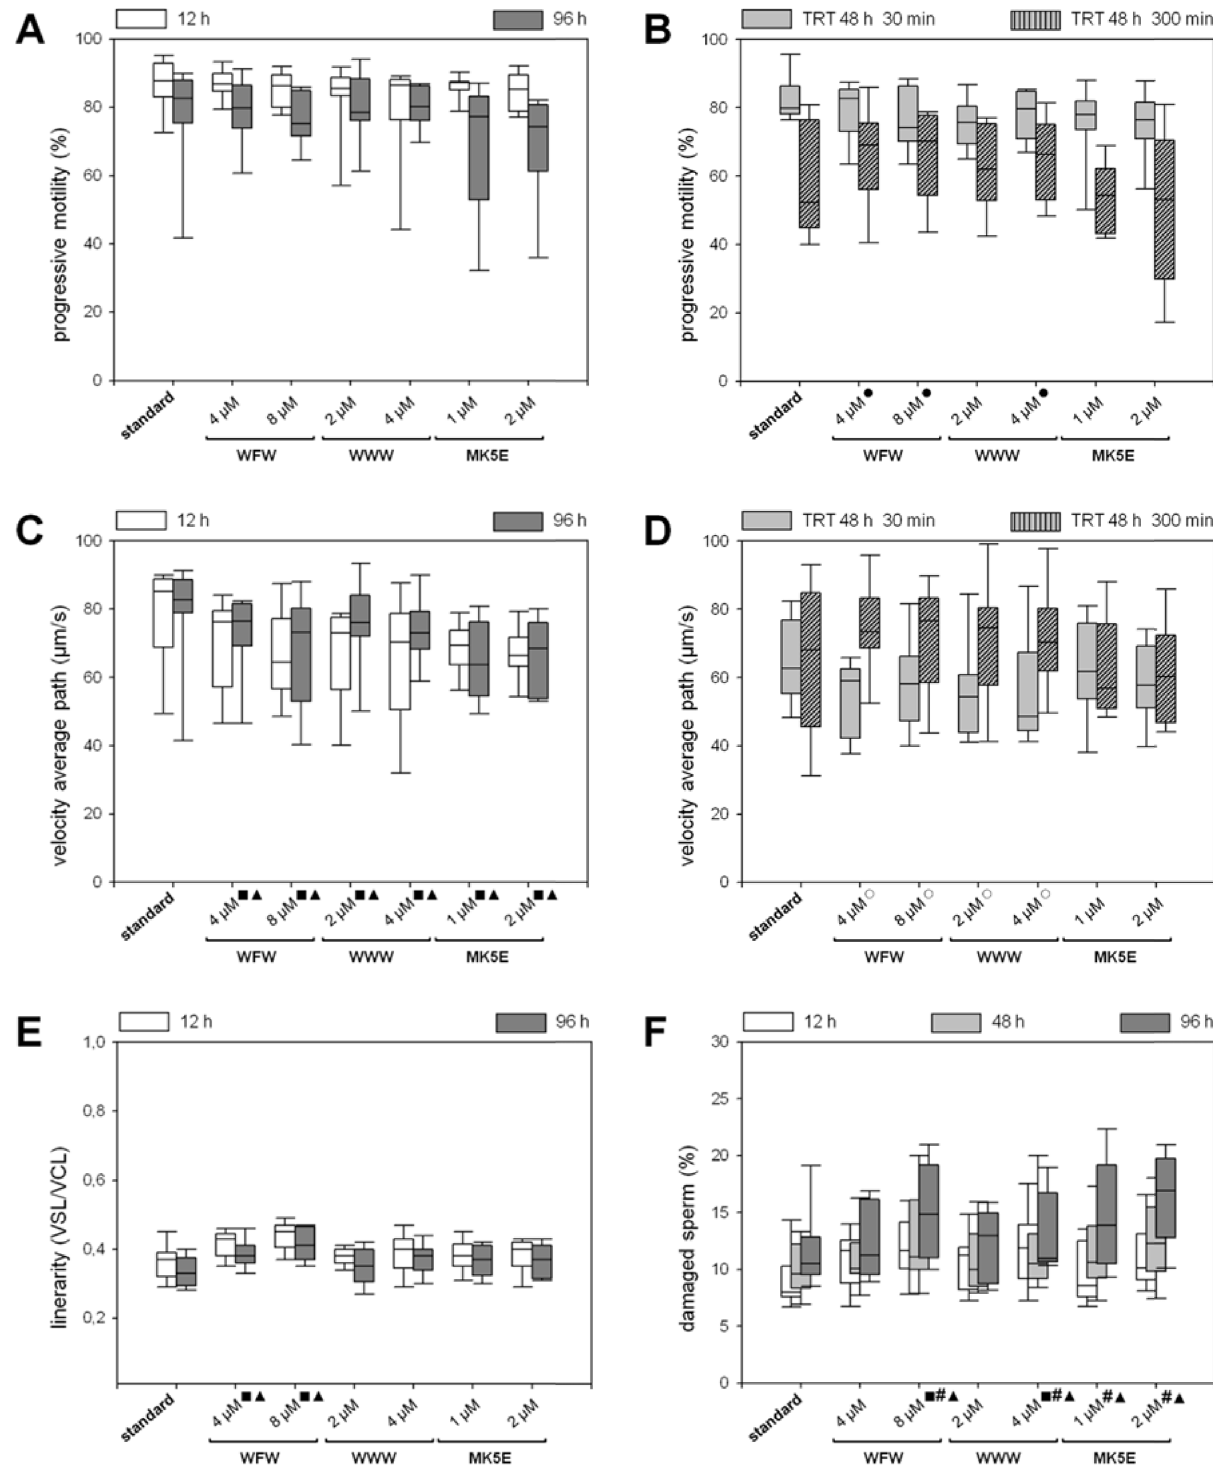
Figure 2. Motion parameters and percentage of damaged boar spermatozoa during BTS preservation at 16 6 C in the presence of 250 m g/mL gentamicin (standard), 4 m M and 8 m M c-WFW, 2 m M and 4 m M c-WWW, and 1 m M and 2 m M MK5E (n=9). The percentage, the velocity (VAP), and the linearity (VSL/VCL) of progressive motile spermatozoa after 12 h and 96 h storage are shown (A, C, E). The percentage and the velocity (VAP) of progressive motile spermatozoa after 48 h storage are shown in a thermoresistance test (TRT, incubation at 38 u C) for 30 and 300 min (B, D). The percentage of damaged spermatozoa was determined after 12 h, 48 h, and 96 h storage by staining with propidium iodide and/ N or markers for the acrosomal membrane and contents (F). Significant difference (see text for the exact P -values) compared to standard after 12 h ( & ), ) incubation at 38 u C. 48 h ( # ), 96 h ( m ) storage, and after TRT 30 min ( # ) and TRT 300 min (